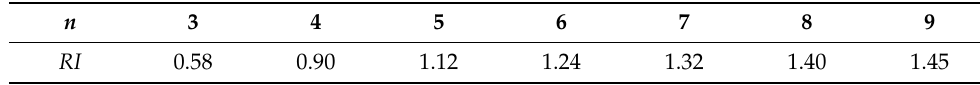
Table 2. Numerical tables of compatibility test RI .